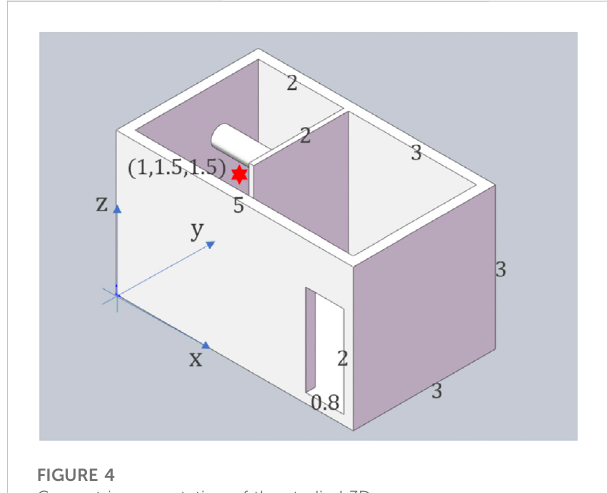
FIGURE 4 Geometric presentation of the studied 3D